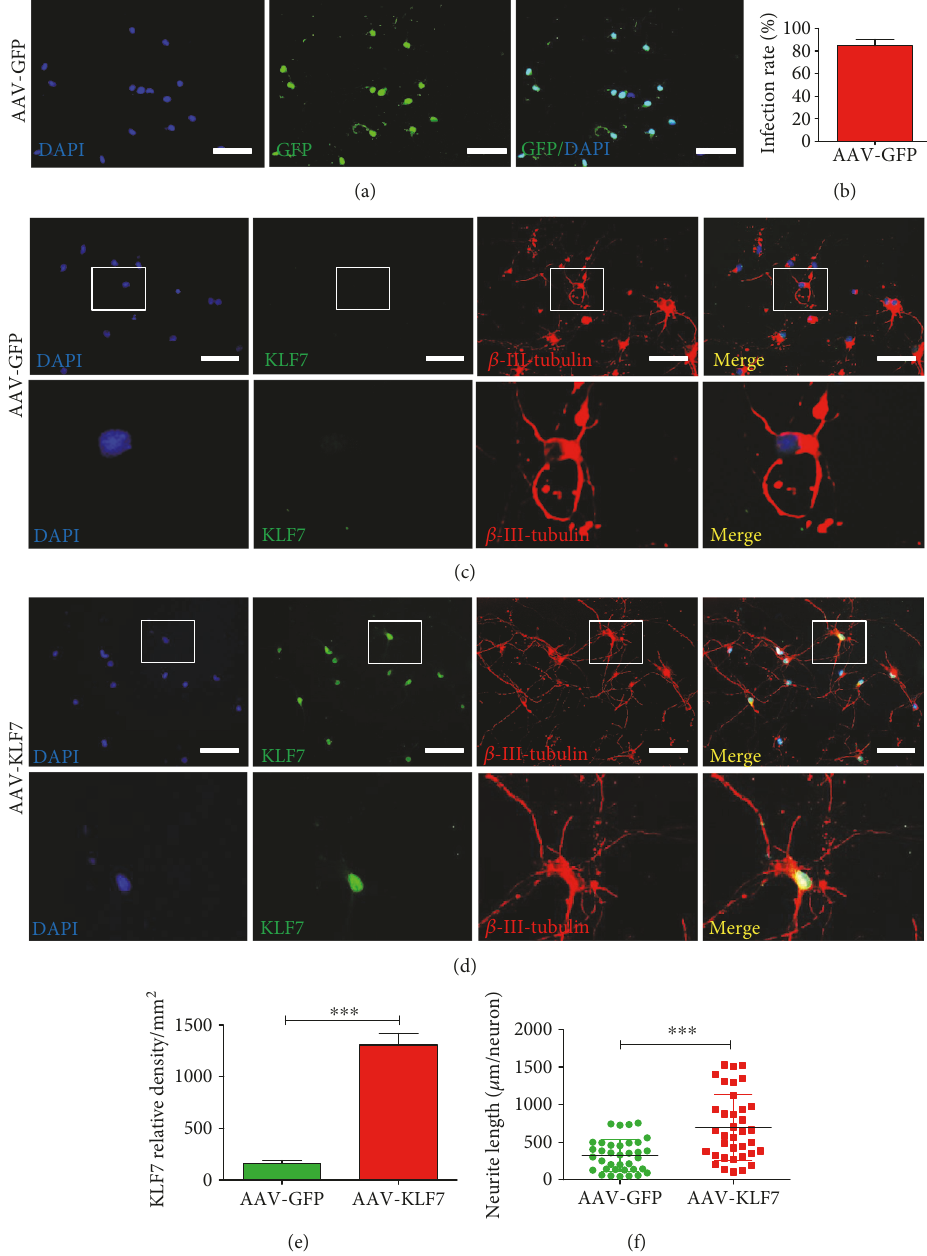
Figure 2: E ffi cacy of AAV2-KLF7 gene transfer to spinal cord neurons in vitro . (a) AAV-GFP-infected cultured spinal cord neurons. Scale bars: 50 μ m. (b) Quantitative analysis of AAV2-GFP infection rate. Representative immunohistochemical staining of KLF7 (green) and β - III-tubulin (labeling neurite and dendrite outgrowth, red) with nuclear staining (DAPI, blue) in cultured spinal cord neurons in the AAV- GFP (c) and AAV-KLF7 groups (d). Block shows the KLF7 colabeling of nuclei and neurite outgrowth. Quantitative analyses of the KLF7 relative density (e) and neurite length/neuron (f) in the two groups. n = 6 wells/group. Student ’ s t -tests, ∗∗∗ P < 0 001 . Scale bars: 200 μ